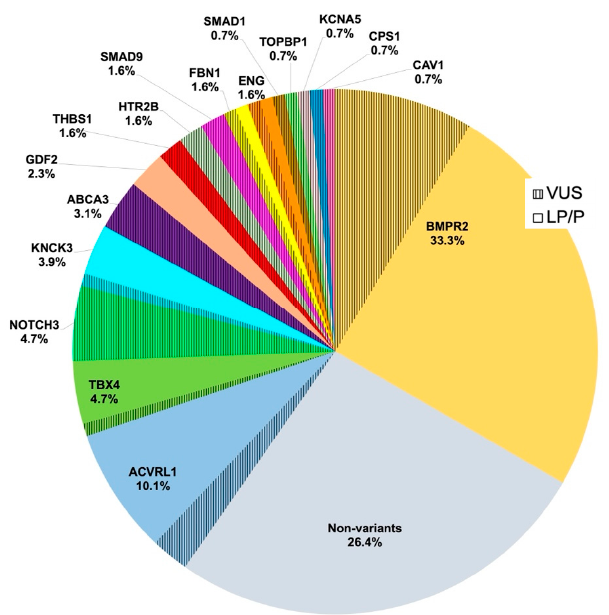
Figure 1. Relative contributions of 17 established PAH risk genes detected in idiopathic paediatric PAH in a cohort of 129 cases. Risk genes included BMPR2, ACVRL1, TBX4, NOTCH3, KCNK3, ABCA3, GDF2, THBS1 (also known as TSP1), HTR2B, SMAD9, ENG, TOPBP1, SMAD1, KCNA5, CPS1, CAV1, and FBN1. PAH, pulmonary arterial hypertension; VUS, variants of uncertain (or unknown) significance; LP/P, likely pathogenic or pathogenic variants in PAH-related genes; % is the percentage of both LP/P and VUS in each gene.